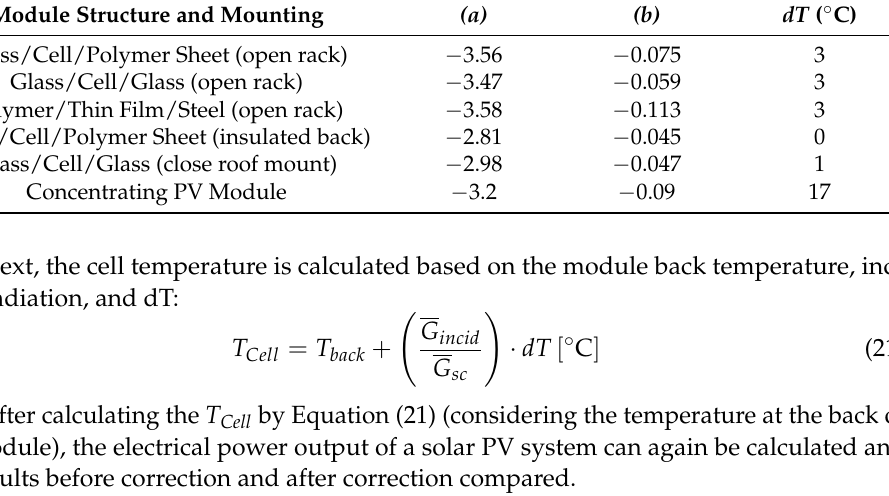
Table 1. Values of the coefficients a , b , and dT . Courtesy of NREL [37]. Module Structure and